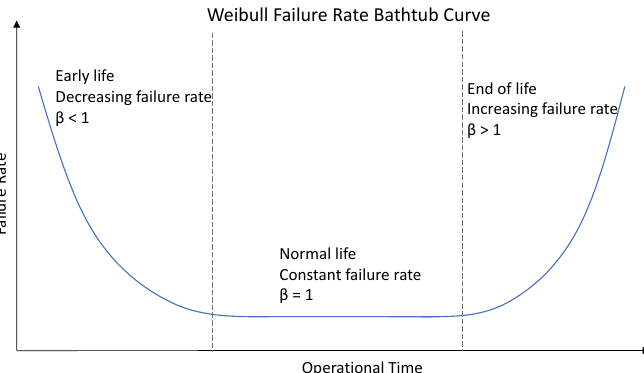
Figure 5. ‘Bathtub’ curve representing common reliability lifetime trend of